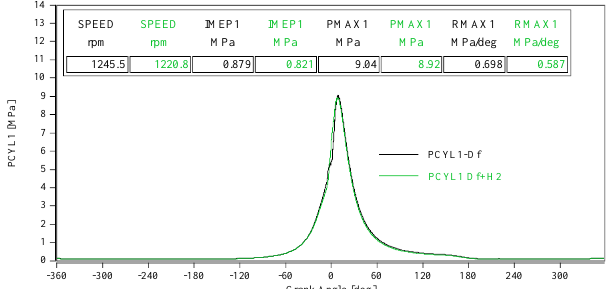
Fig. 8. Mean indicated pressure for 100 subsequent working cycles of the engine powered by diesel oil (black colour) and diesel oil and HHO (green Fig. 12. Internal combustion chamber pressure during vehicle acceleration colour), a vehicle driving with engine rotational speed of about 2000 rpm – for second gear at engine speed 1245 rpm, for diesel (black colour) and gear 4; additionally, the tables show minimum, maximum, average and diesel and H (green colour), in addition the table shows the mean index standard deviation for average indicator pressure (IMEP1) and engine pressure (IMEP1), maximum combustion pressure (PMAX1), maximum speed pressure rise speed (RMAX1) and engine speed (SPEED)